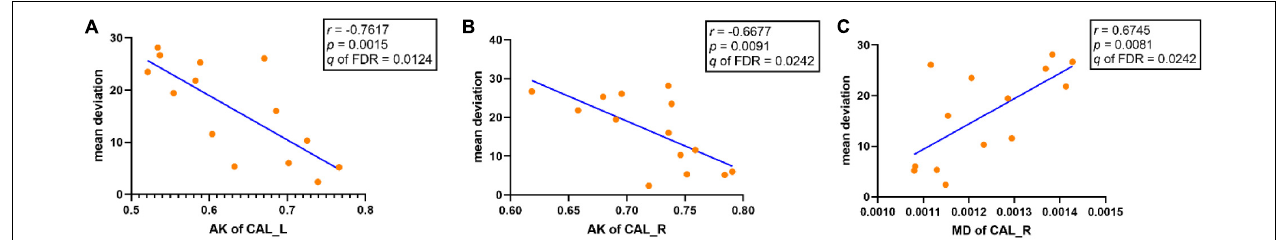
FIGURE 2 | Significant correlations between altered DKI metrics and clinical features in the NMOSD-ON group ( q < 0.05, FDR corrected). (A) AK of the left CAL was negatively correlated with mean deviation. (B) AK of the right CAL was negatively correlated with mean deviation. (C) MD of the right CAL was positively correlated with mean deviation. AK: axial kurtosis; MD, mean diffusivity; CAL, calcarine; FDR, false discovery rate; L, left; R, right.